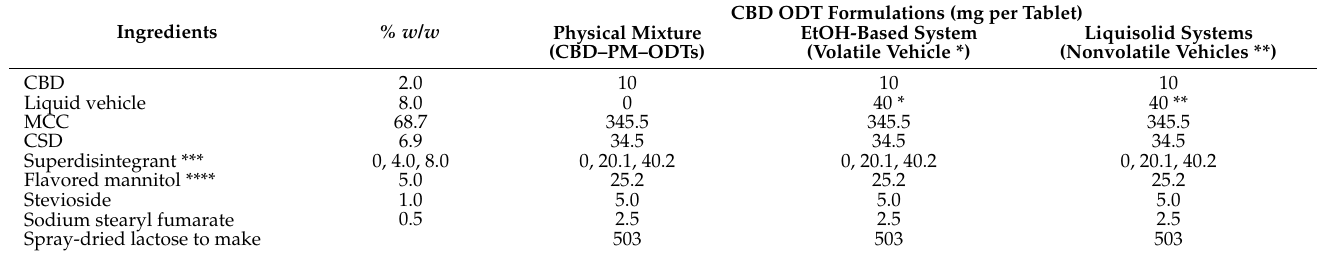
Table 1. General formulation compositions of CBD